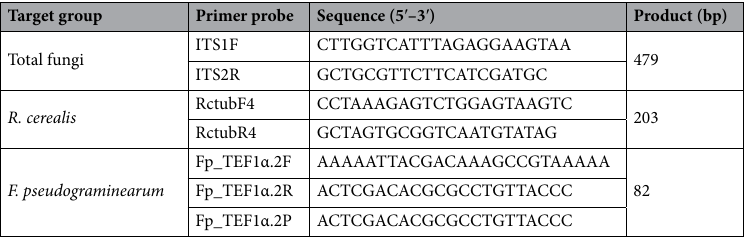
Table 1. Quantitative PCR primer